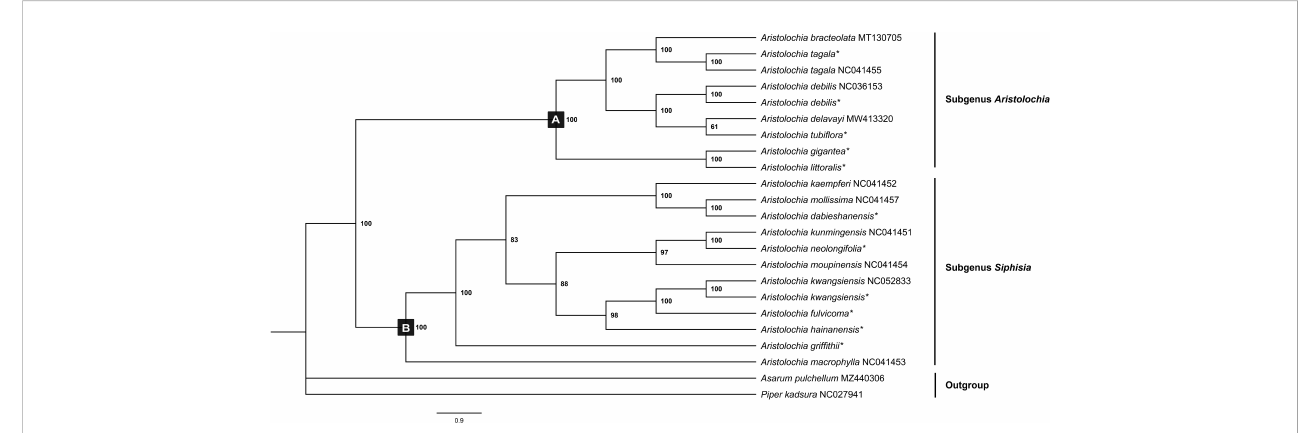
FIGURE 6 Phylogenetic tree inferred from the CDS of the 72 protein-coding genes of Aristolochia species using Maximum Likelihood (ML) method. The numbers near by nodes are values for bootstrap support. Species with newly sequenced chloroplast genomes are marked with asterisks.